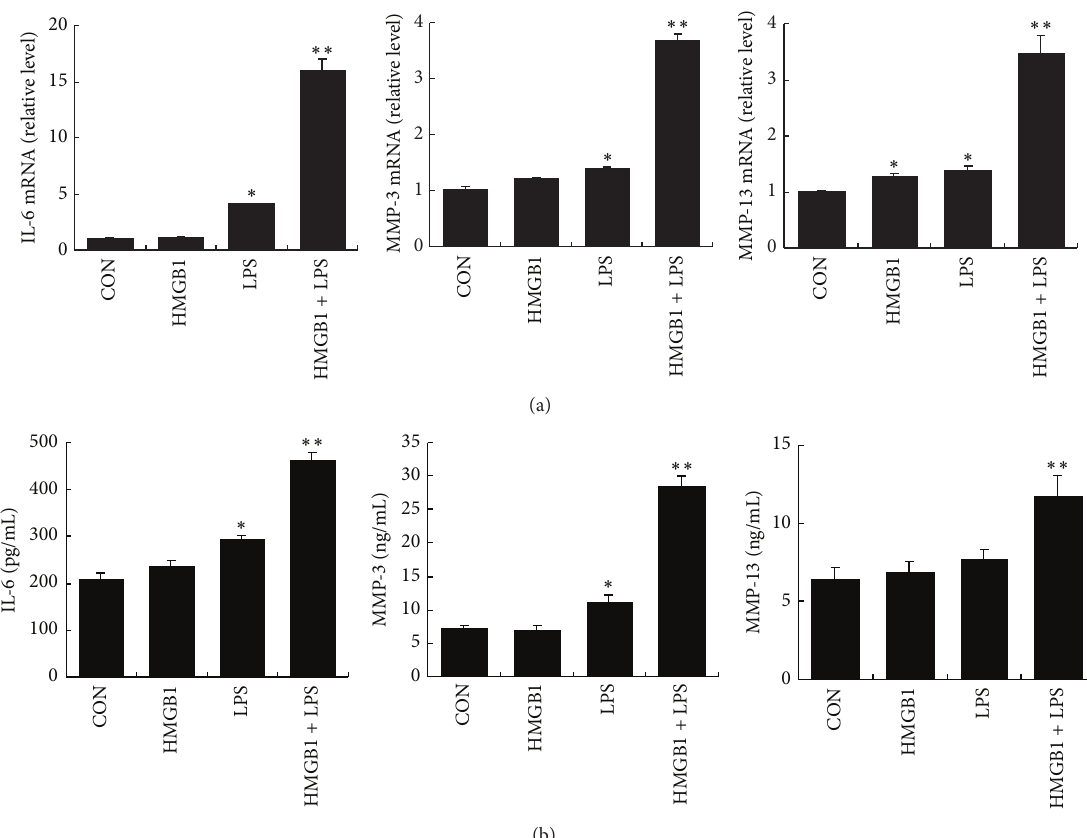
Figure 2: HMGB1 acted in synergy with LPS to induce IL-6, MMP-3, and MMP-13 expression in cultured SF. IL-6: interleukin-6; MMP: matrix metalloproteinase. (a) mRNA expression levels of IL-6, MMP3, and MMP-13 were analyzed by quantitative real-time RT-PCR. Total RNA was isolated from cultured SF stimulated with 10ng/mL of LPS and/or 100 ng/mL of HMGB1 for 3 h. (b) The concentrations of IL-6, MMP-3, and MMP-13 proteins in culture supernatants were measured by ELISA using commercial kits. The supernatants were collected after the cultured SF were stimulated with 10ng/mL of LPS and/or 100ng/mL of HMGB1 for 48h. Data are expressed as mean ± SD ( 𝑛 = 4 ). ∗ 𝑃 < 0.05 and ∗∗ 𝑃 < 0.01 compared with control (unstimulated